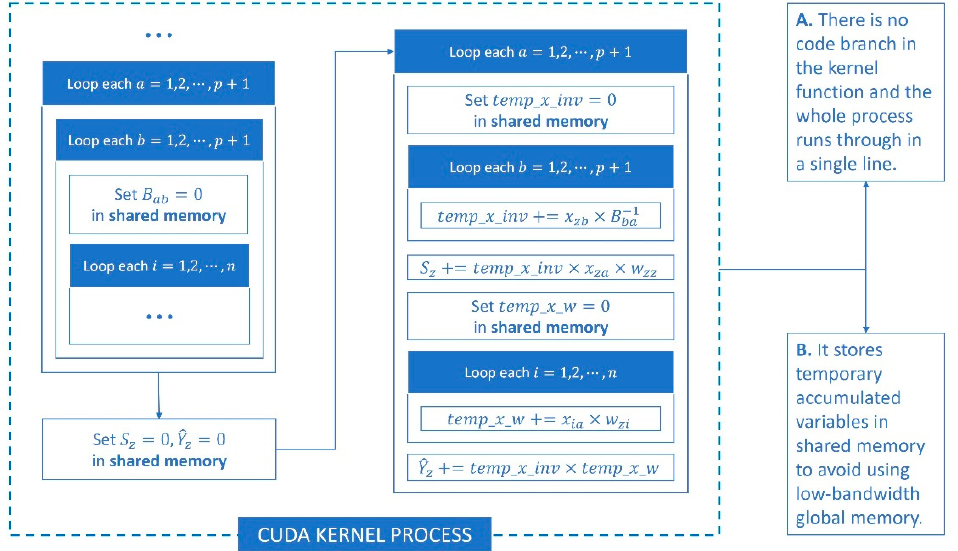
Figure 1. Optimizing the compute unified device architecture (CUDA) kernel function.